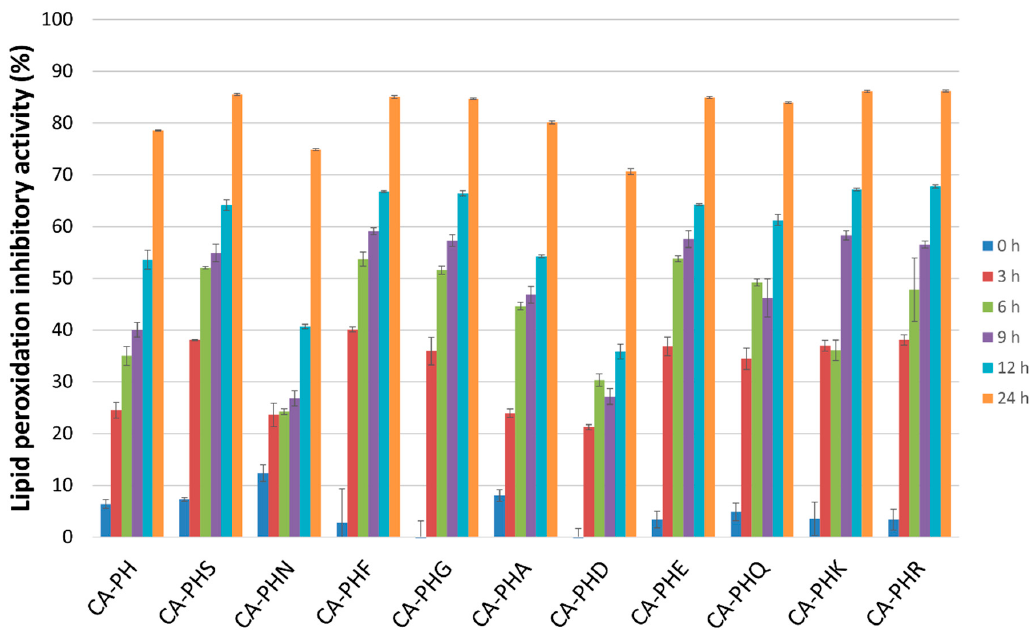
Figure 3. Antioxidant activity of the CA-PHX-NH 2 derivatives under lipid peroxidation conditions. Each experiment was performed in triplicate. Results are presented as mean ± standard error.